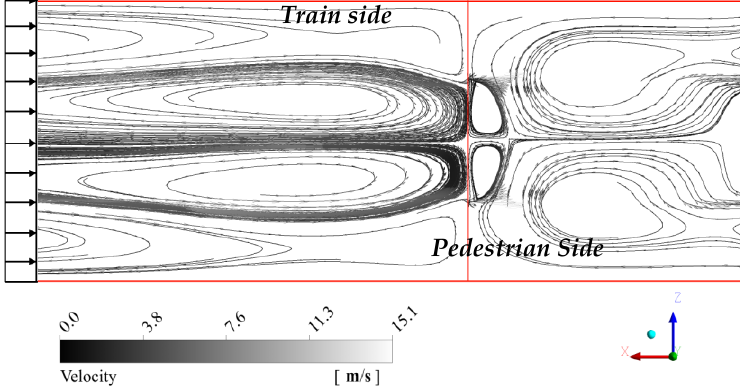
Figure 7. Streamlines and vectors around the PSD gaps (pressure-inflow at 50 Pa).